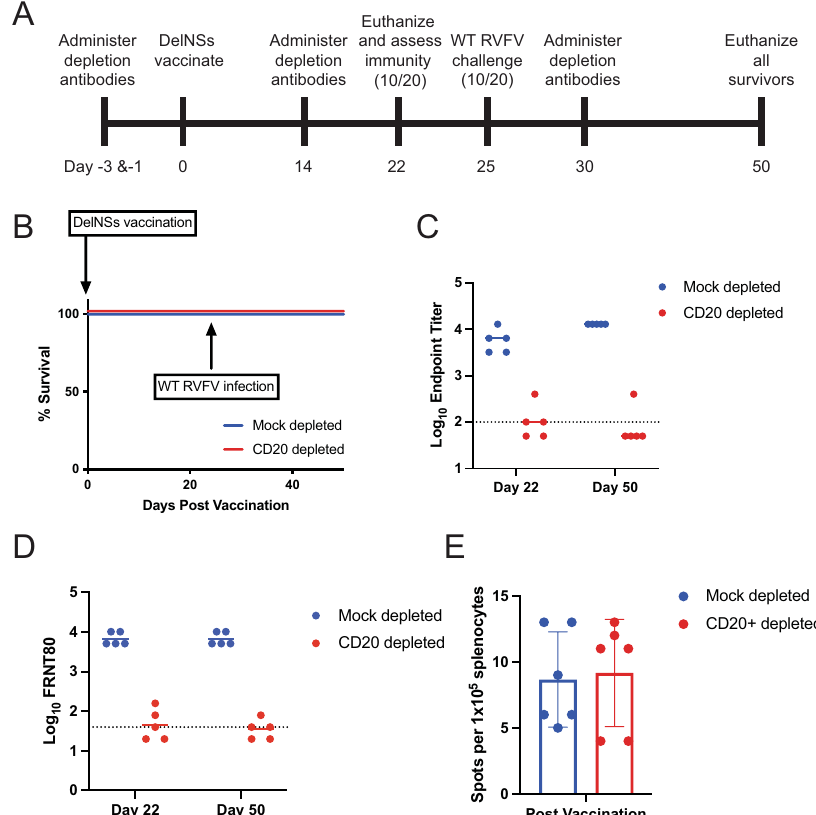
Fig. 2 RVFV-speci fi c antibodies are largely dispensable for survival in the presence of pre-existing RVFV-speci fi c T cells. Mice ( n = 10 per experimental group) were depleted of CD20 + lymphocytes or mock-depleted, then vaccinated with 2 × 10 5 TCID 50 DelNSsRVFV. Half were euthanized for immune assessment, and the other half were challenged with 2 × 10 5 TCID 50 of WT RVFV ( A ). Animals were monitored for survival ( B ). Endpoint titers of RVFV-speci fi c antibodies by ELISA ( C ) or neutralizing antibody titers ( D ) were measured 22 days after vaccination/prior to WT challenge, and again at the end of the experiment. The dotted line is the LOD (100 for ELISA, 40 for FRNT 80 ). Negative values were plotted at 50 and 20, respectively. The geometric mean titer is noted for each group. The number of RVFV-speci fi c T cells in total splenocytes was determined by IFN- γ ELISPOT assay, expressed as the number of spots per 1 × 10 5 splenocytes ( n = 3, in duplicate) ( E ). Mean and standard deviation are